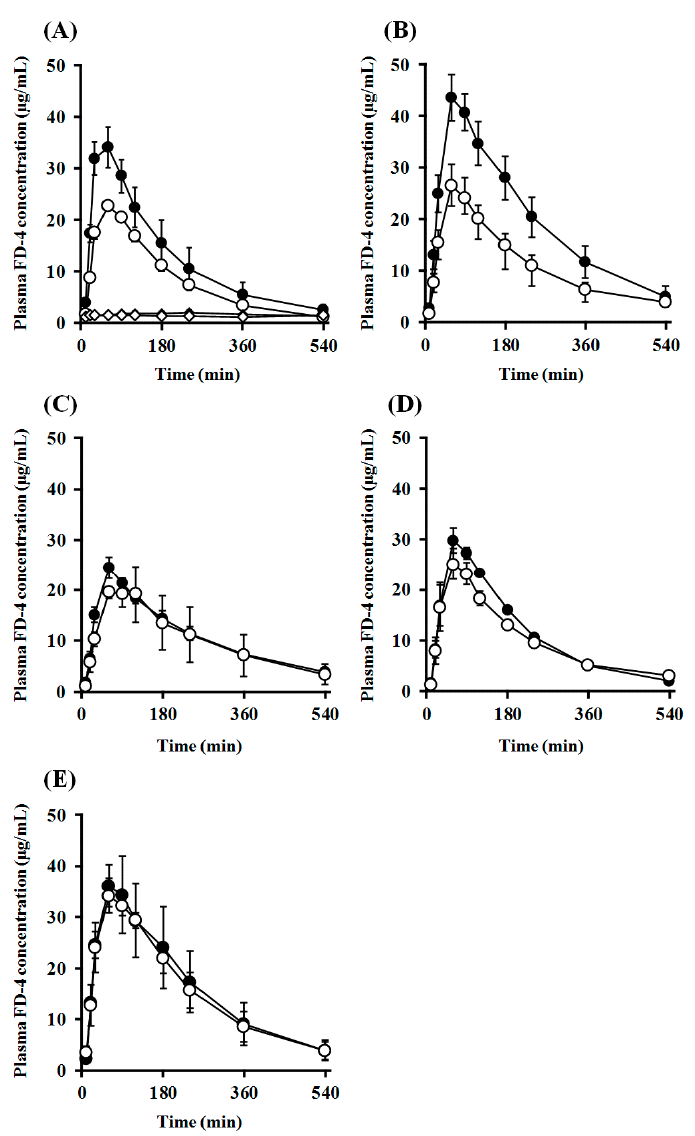
Figure 10. Comparison of plasma FD-4 concentration after i.n. administration in rats under closed and open systems; ● : Closed system, ○ : Open system; ( A ): PLO (0.25%) ( ♦ and ◊ indicate the control group in the closed and open systems, respectively); ( B ): PLO (0.50%); ( C ): PEG-PLO (0.50%); ( D ): PEG-PLO (1.00%); ( E ): PEG-PLO (2.00%). Each data point represents the mean ± S.E. ( n = 3–7).